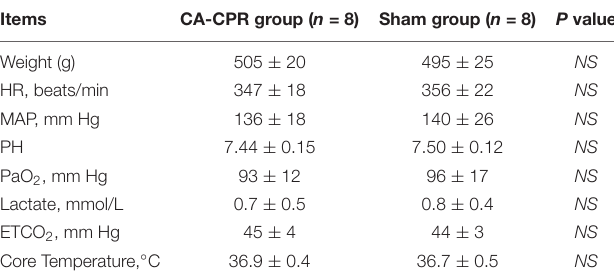
TABLE 1 | Baseline parameters of the two experimental